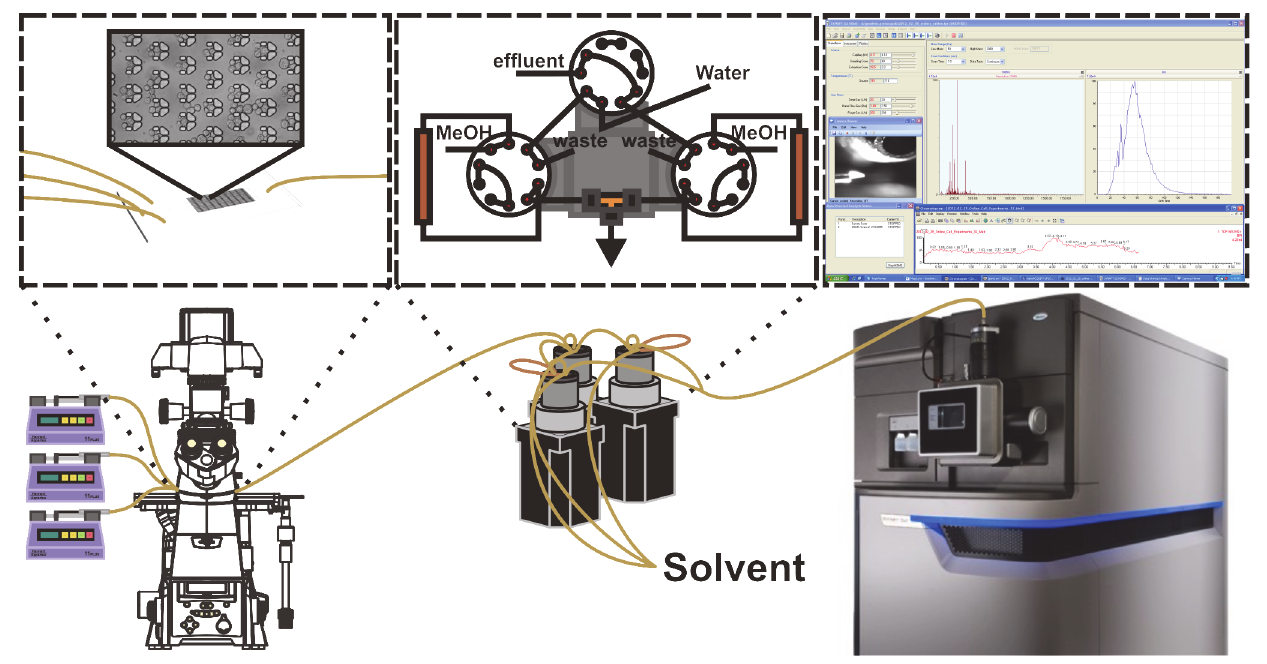
Fig 4. Multitrap Nanophysiometer (MTNP)-solid phase extraction (SPE)-nanoelectrospray ionization (nESI)-ion mobility (IM)-mass spectrometry (MS) platform. The platform includes Harvard Apparatus syringe pumps, a Nikon Eclipse Ti-e inverted fluorescence microscope with stage incubator, a solid phase extraction desalter with Eksigent and nanoAcquity pumps for solvent flow control, and a nanoelectrospray ionization source for continuous flow sample analysis with the Waters Synapt G2 ion mobility-mass spectrometer. Beyond the initial experimental setup, all components are fully automated and capable of running multi-hour experiments limited by the lifetime of cells in the